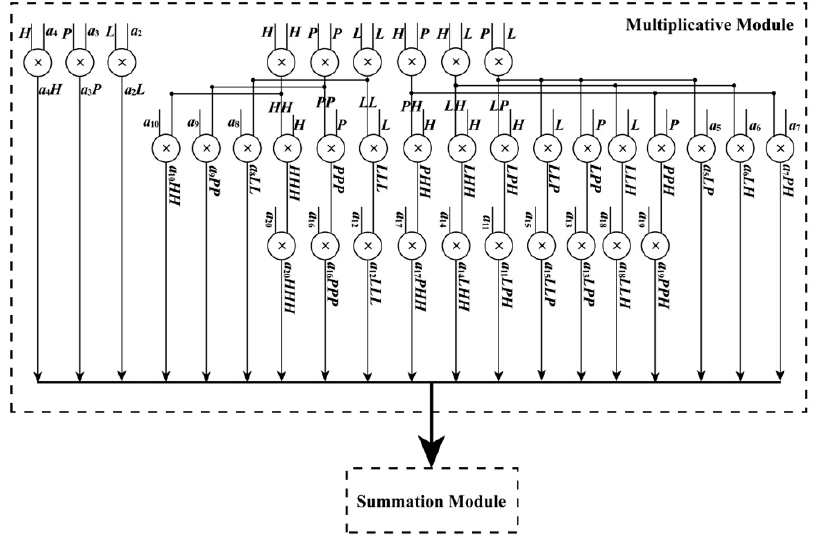
Figure 5. Schematic diagram of polynomial module.